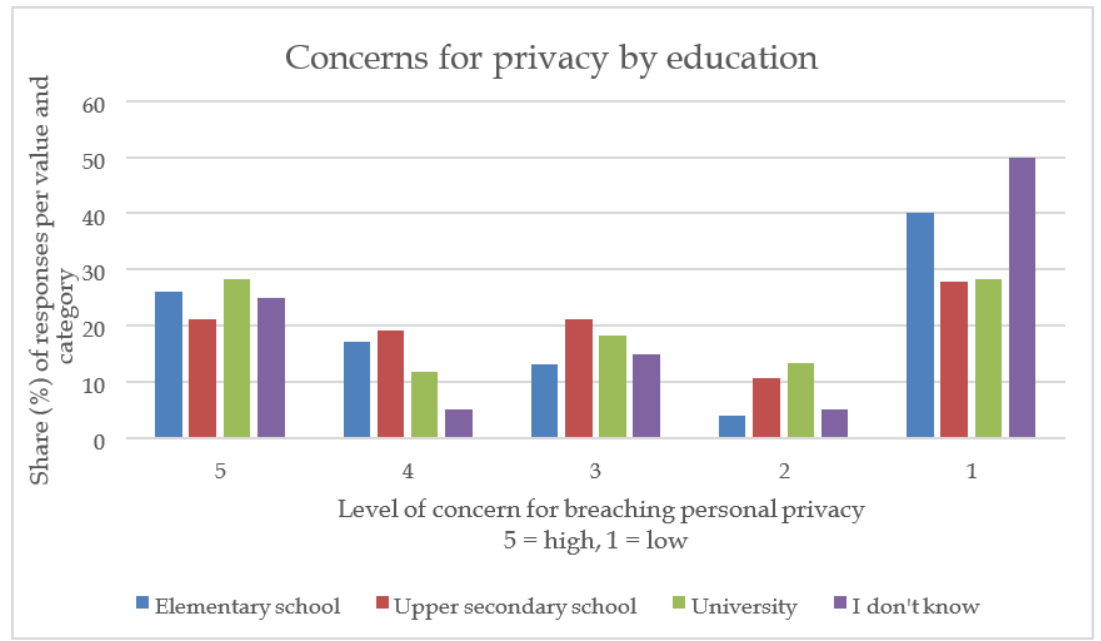
Figure 4. Concerned for breaching privacy and education. Percentage per reported value on scale 5-1. Elementary school n=100 (100%), Upper secondary school n=104 (100%); University or higher n=60 (100%). I don’t know n=20 (100%). Total n=284.